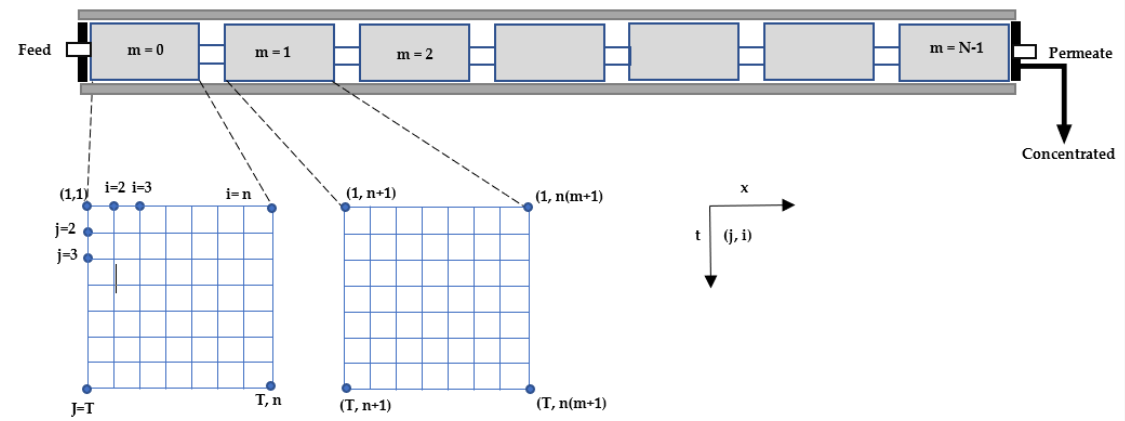
Figure 6. ISD system optimization using finite difference approximation source [54].